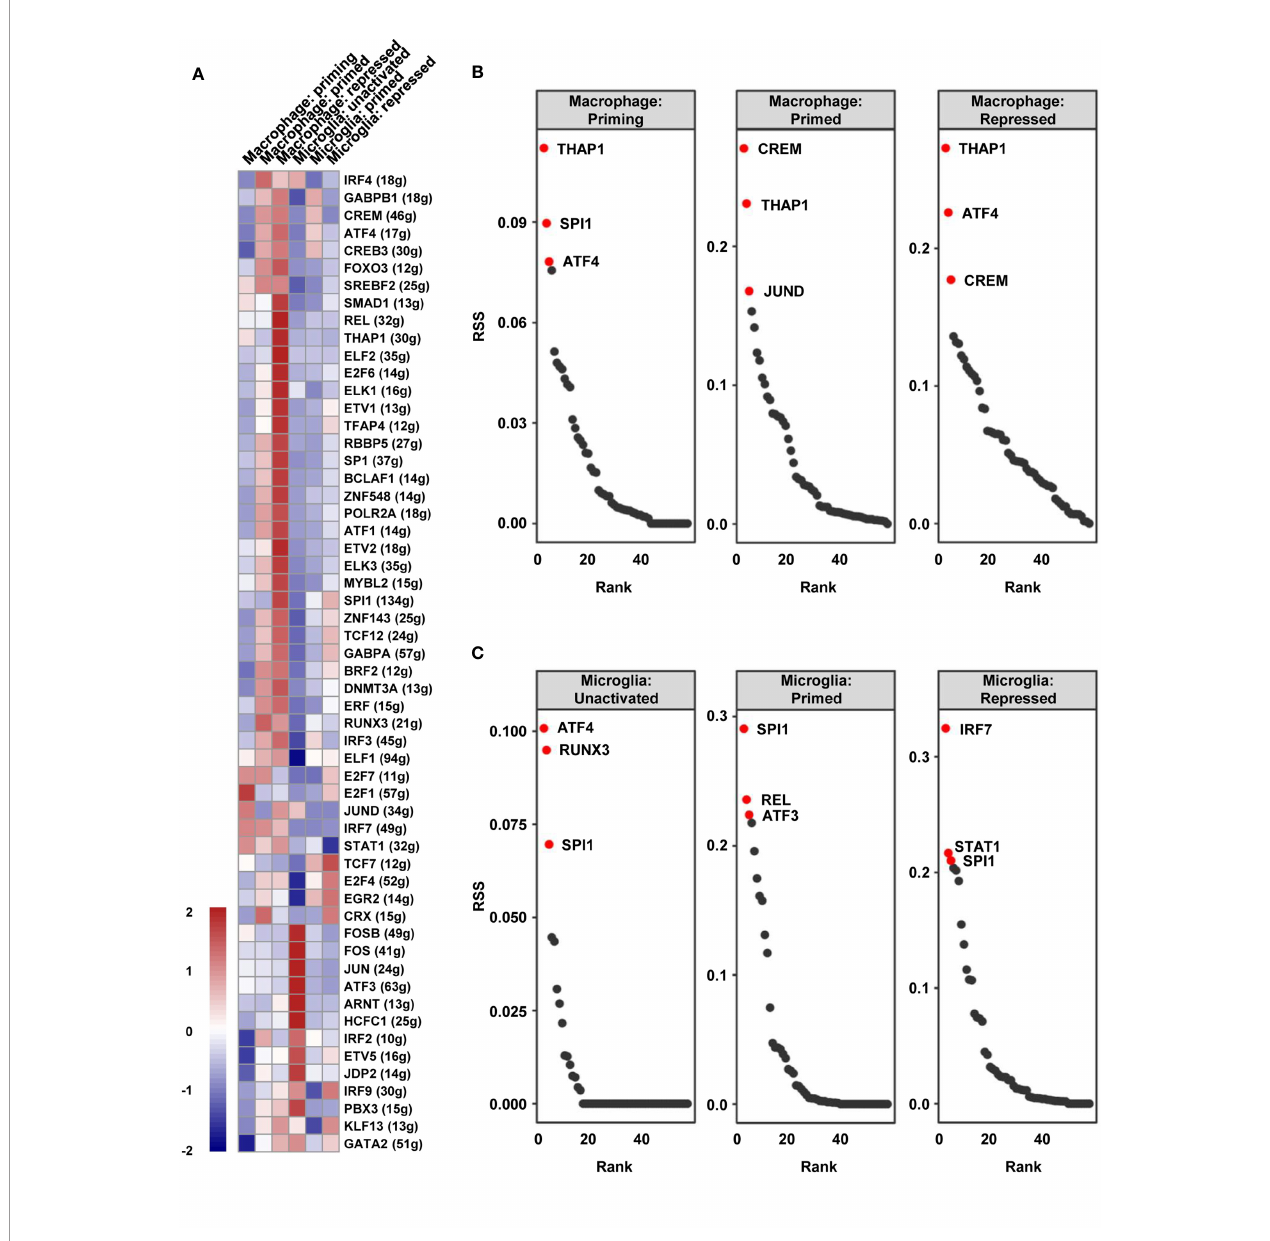
FIGURE 5 | The vital regulons in each cell type of TAMs. (A) The RAS of every regulon in different cell types was visualized as a heat map. (B, C) The ordered regulons based on the RSS were shown as sequence